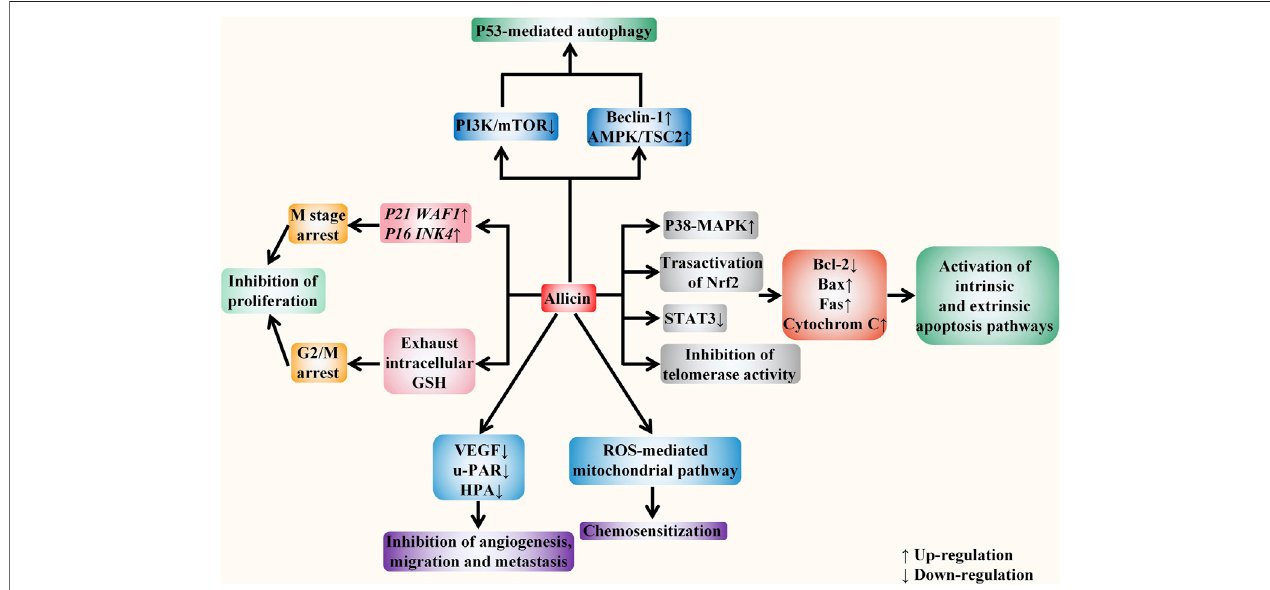
FIGURE 5 | Allicin acts against digestive system cancers in vitro . The anticancer effect of allicin in vitro is mainly re fl ected in fi ve aspects, including inhibiting proliferation, inducing apoptosis, inducing autophagy, inhibiting angiogenesis, invasion, and metastasis, and enhancing the sensitivity of tumor chemotherapy. It depletesintracellularglutathione(GSH) and up-regulates p21WAF1 and p16INK4 genestoblockthe cellcycle and inhibit cellproliferation. Itactivates both endogenous and exogenous apoptotic pathways by regulating intracellular signaling pathways, inhibiting telomerase activity, and regulating the activity of apoptosis-related proteins. In addition, it also down-regulates the PI3K/mTOR signaling pathway and up-regulates the AMPK/TSC2 and Beclin-1 signaling pathways to induce the P53 mediatedautophagy.Itinhibitstumorangiogenesis,migration,andmetastasisbydown-regulatingVEGF,u-PAR,andHPA.Moreover, via ROS-mediatedmitochondrial pathway, it exerts the chemosensitization effect towards tumor cells.